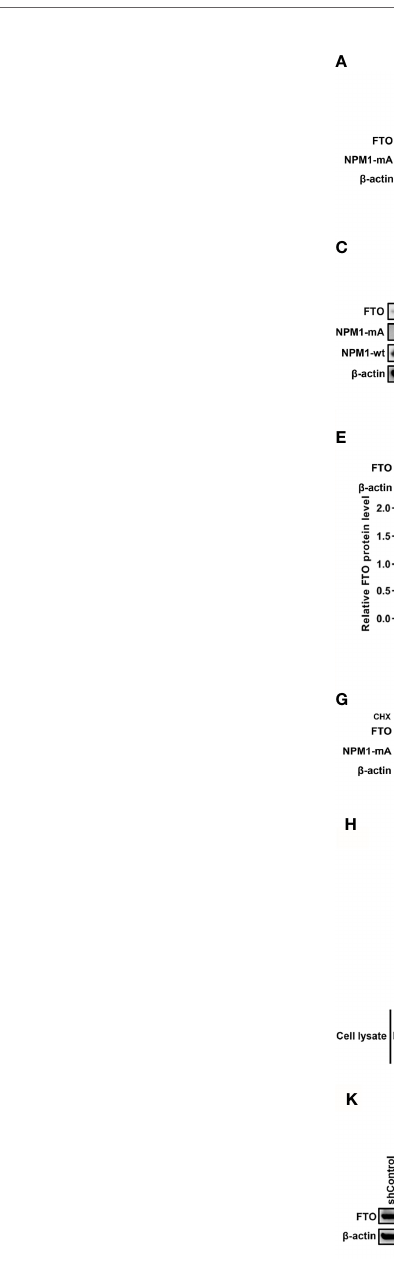
FIGURE 2 | NPM1-mA Upregulates FTO Expression to Reduce the m 6 A Level through Impeding the Proteasome Pathway. (A, C) Western blot analysis of the FTO, NPM1-mA, and NPM1-wt protein level in the NPM1-mA-silenced OCI-AML3, NPM1-wt-enforced OCI-AML2, and NPM1-mA-enforced OCI-AML2 cells. The bar graph showed the relative level of protein. (B, D) qRT-PCR analysis of the FTO, NPM1-mA, and NPM1-wt mRNA level in the NPM1-mA-silenced OCI-AML3, NPM1- wt-enforced OCI-AML2, and NPM1-mA-enforced OCI-AML2 cells. (E) OCI-AML3 cells were treated with the ubiquitin-proteasome pathway inhibitor MG132 (20 m M), the autophagic-lysosomal pathway inhibitor CQ (20 m M), and activator rapamycin (20 m M) for 8 h. The bar graph showed the relative level of FTO protein. (F) Western blot analysis of the FTO protein level in the NPM1-silenced OCI-AML3 cells following treatment with MG132 (20 m M) for 8h. The bar graph showed the relative level of FTO protein. (G) Western blot analysis of the FTO and NPM1-mA protein level in the NPM1-mA-silenced OCI-AML3 cells following treatment with the protein synthesis inhibitor CHX (100 m g/mL) for the indicated time. The line graph showed the degradation rate of FTO protein. (H) Ubiquitination analysis of the ubiquitinated FTO level in the NPM1-mA-silenced OCI-AML3 cells. b -actin was used as the internal control. (I, J) m 6 A dot blot analysis of the global m 6 A abundance in the NPM1-mA-silenced OCI-AML3, NPM1-wt-enforced OCI-AML2, and NPM1-mA-enforced OCI-AML2 cells. Methylene blue staining served as a loading control. (K) Western blot analysis of the FTO protein level in the NPM1-mA-silenced OCI-AML3 cells transfected with the HA-FTO plasmids. The bar graph showed the relative level of FTO protein. b -actin was used as the internal control. (L) m 6 A dot blot analysis of the global m 6 A abundance in the NPM1-mA-silenced OCI-AML3 cells transfected with the HA-FTO plasmids. Methylene blue staining served as a loading control. Data were presented as the mean ± SD of three independent experiments. * P < 0.05, **P < 0.01, ***P < 0.001; N.S. indicated not signi fi